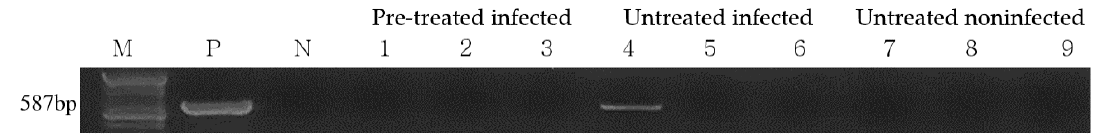
Figure 4. PCR analysis of the EPC cells inoculated with intestine, kidney, or spleen tissue homogenates from olive flounder ( Paralichthys olivaceus ). Lanes 1, 4, and 7 = intestine; lanes 2, 5, and 8 = kidney; lanes 3, 6, and 9 = spleen; N = negative control (deionized sterile water); P = positive control (VHSV); M: 100 bp DNA ladder.